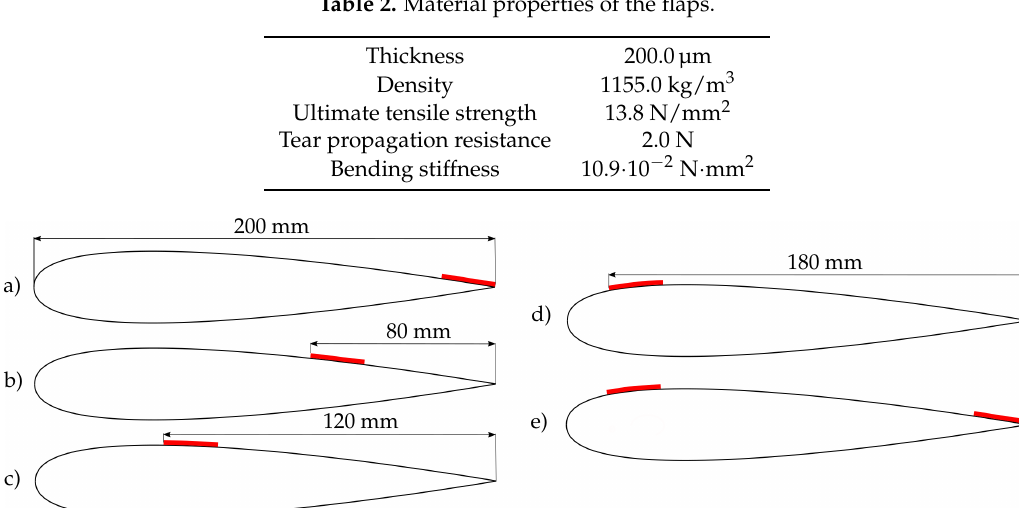
Table 2. Material properties of the flaps.